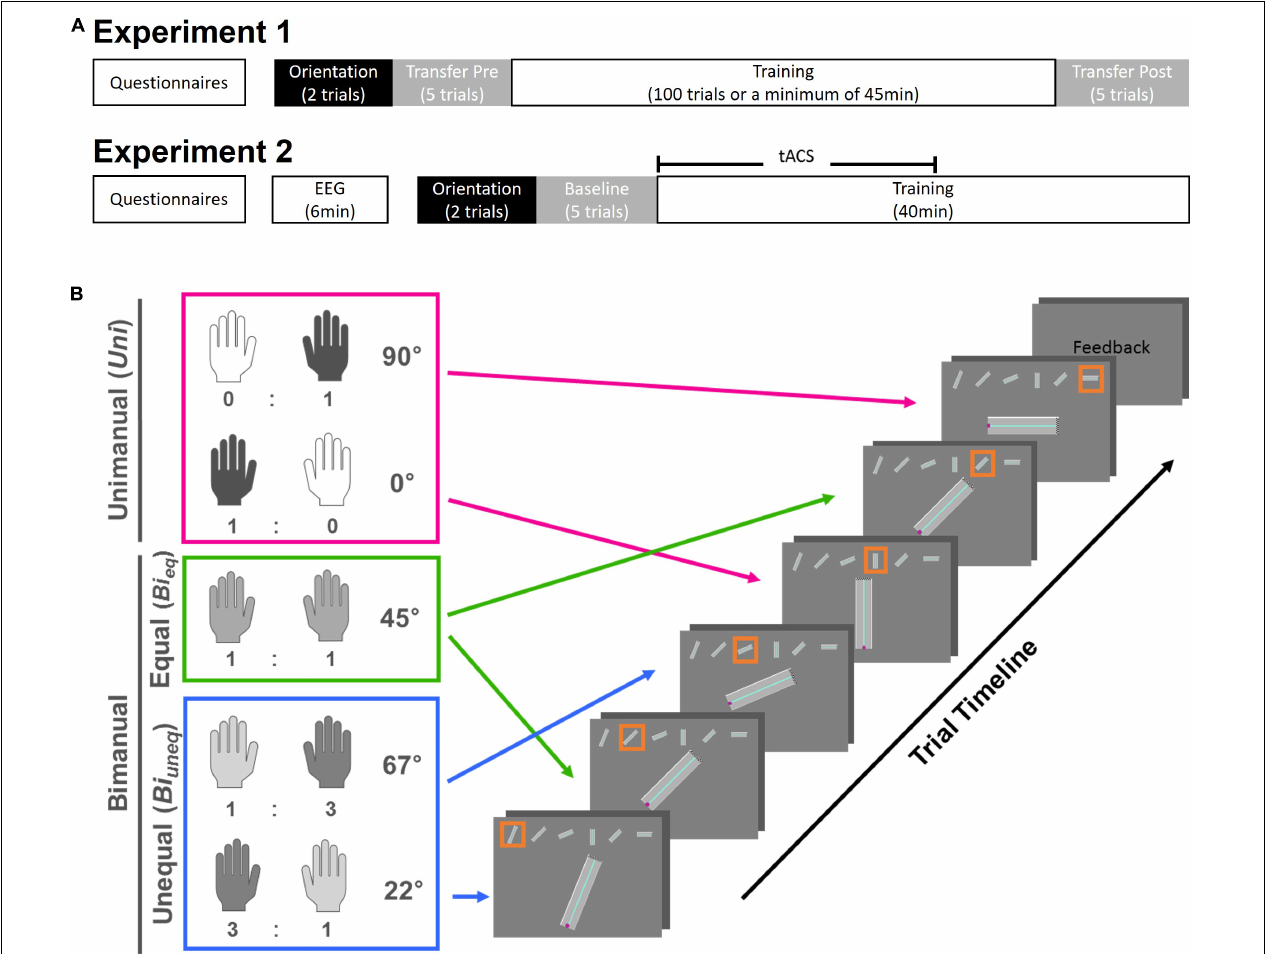
FIGURE 1 | Schematic overview of the experimental timeline (A) and task design (B) . (A) In experiment, participants filled in questionnaires and performed 45 min of the training task with a minimum of 100 trials. In experiment 2, after filling in questionnaires and identifying the beta peak frequency with EEG, participants performed the training task for 40 min. For each experiment, before learning the training task, two orientation trials were given and the hand-axis configuration was swapped, i.e., transposed, for five trials (Transfer Pre). In experiment 1, this transposition was also performed for five trials after learning (Transfer Post). In experiment 2, the transposition was used as a baseline measurement to allocate participants to stimulation groups. (B) Each trial consisted of three conditions, i.e., Uni (pink), Bi eq (green), and Bi uneq (blue). The ideal left- and right-hand ratios with the corresponding street angles are shown. Each condition was present twice in one trial; therefore, one trial would consist of one path with six streets. Each street was displayed in the middle of the screen with the whole path on top. The orange frame indicated on which street participants were currently on. After finishing the path, participants received feedback on their performance (time and accuracy) and started the next path in a self-paced